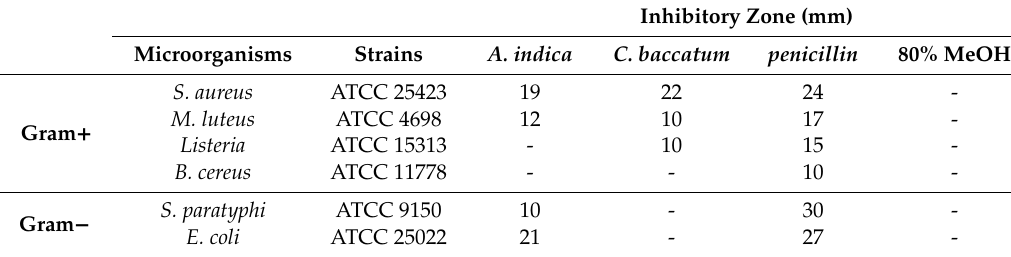
Table 2. Antibacterial activity of A. indica and C. baccatum extracts determined by inhibitory zone